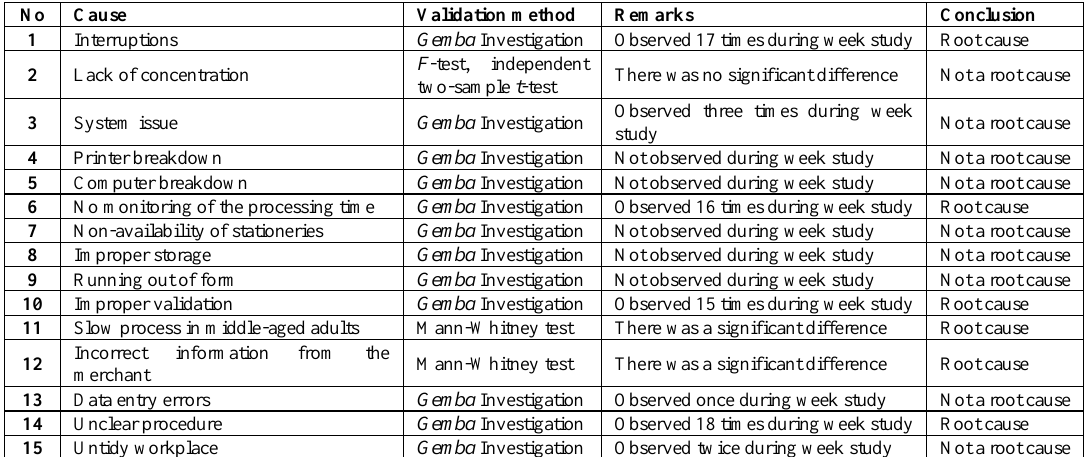
Table 3. Details of cause